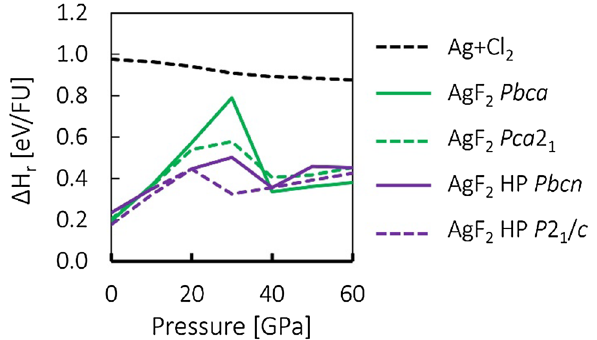
Figure 10. Comparison of ΔH r pressure dependence for original (solid line) and phonon-relaxed (dashed line) structures of AgF 2 and HP-AgF 2 polymorphs of AgCl 2